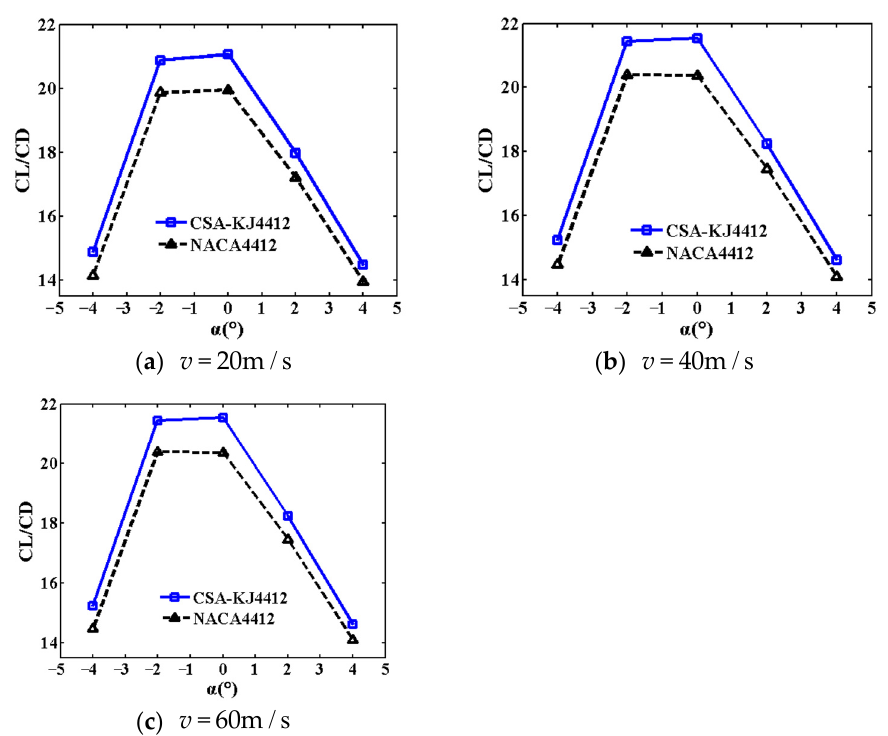
Figure 7. Variation of lift-drag ratio with angle of attack at different incoming wind speeds.